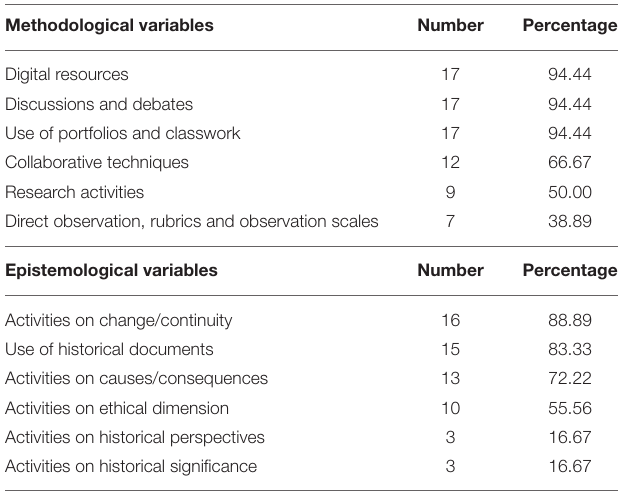
TABLE 2 | Methodological and epistemological variables introduced in the teaching units designed by the master’s